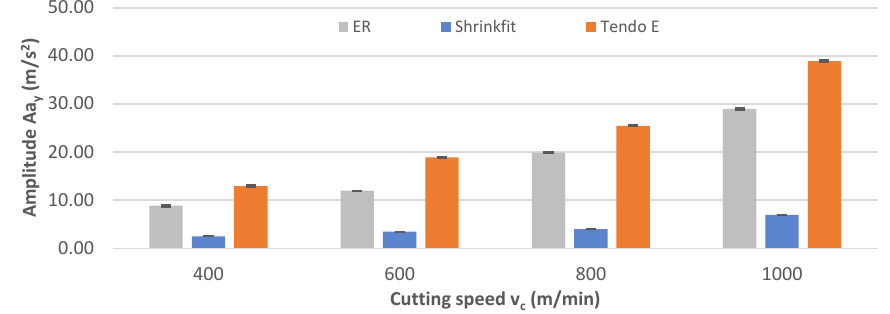
Figure 13. Impact of cutting speed v c on the vibration acceleration amplitude Aa y (f z = 0.15 mm/tooth, a p = 6 mm).